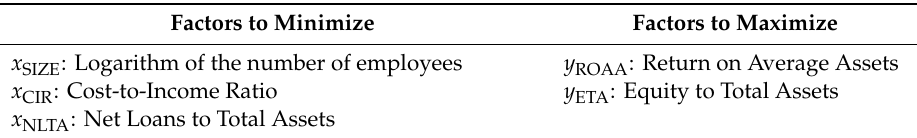
Table 4. The direction of optimization for